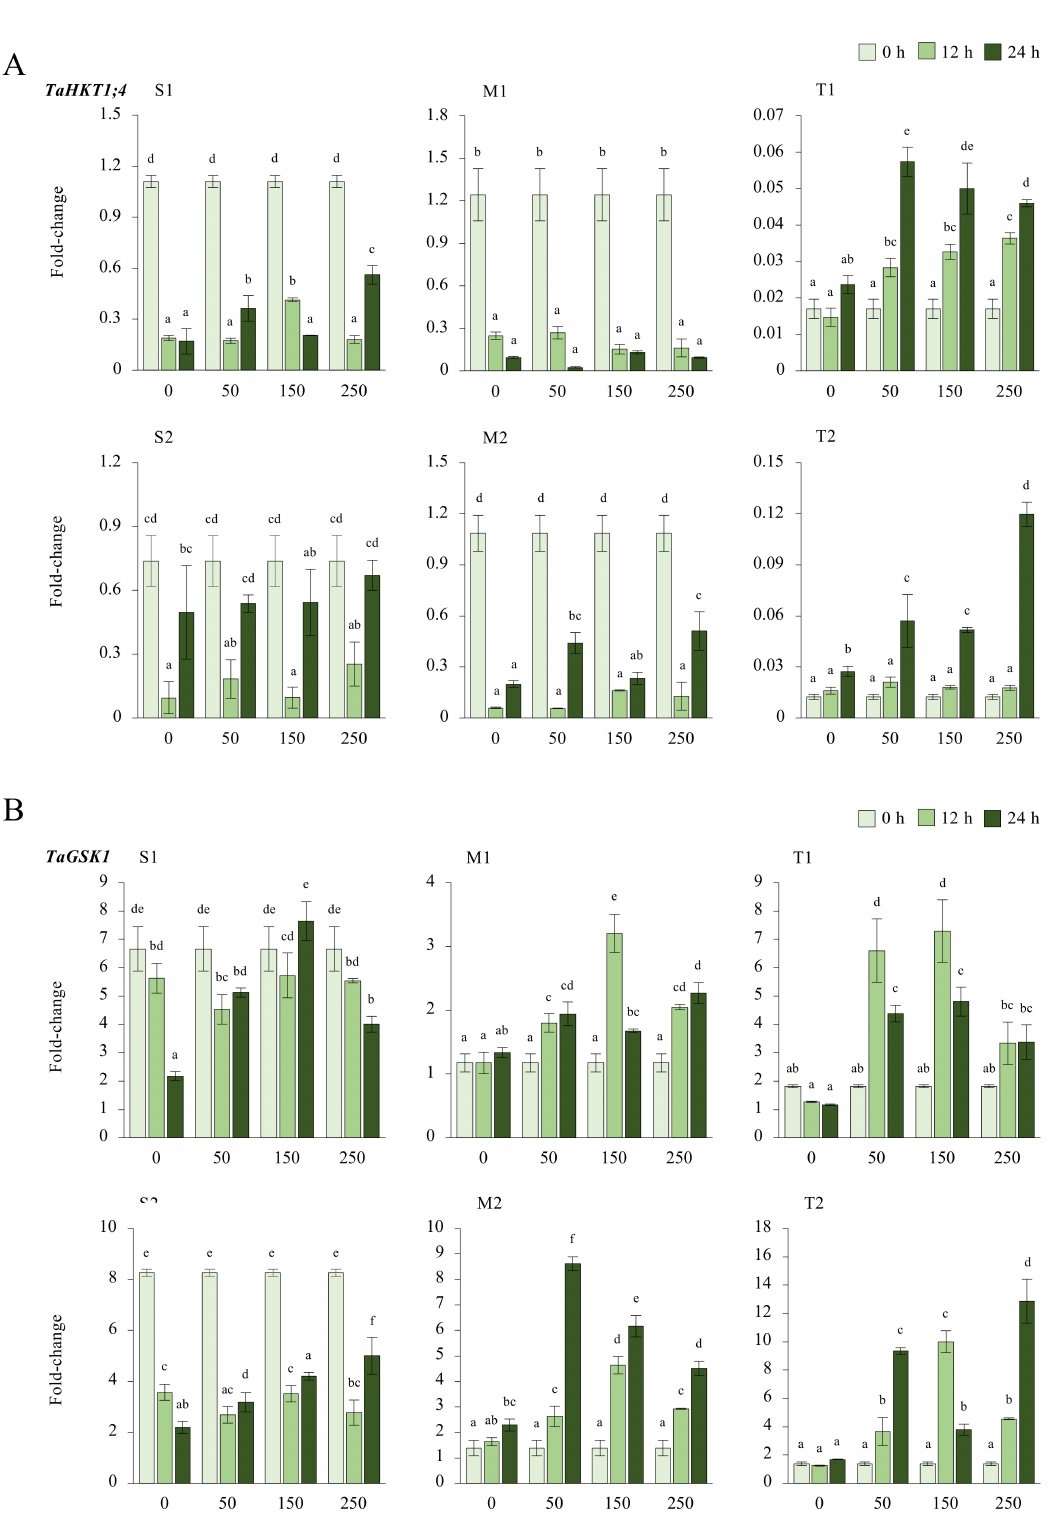
Figure A5. ( A ) The gene expression of the TaHKT1;4 gene, and ( B ) TaGSK1 in the leaves of salt- sensitive (S1), S2, -moderate (M1), M2, -tolerant (T1), and T2 genotypes exposed to 0, 50, 150, and 250 mM NaCl stress for 0, 12, 14 h. The Cq values formed the basis of qRT-PCR. The reference gene TaACTIN was used to standardize the Cq value for each sample. Means ( ± standard deviation) within the same graph followed by letters are significantly different at p < 0.05 according to the Tukey HSD test from independent biological triplicates ( n =